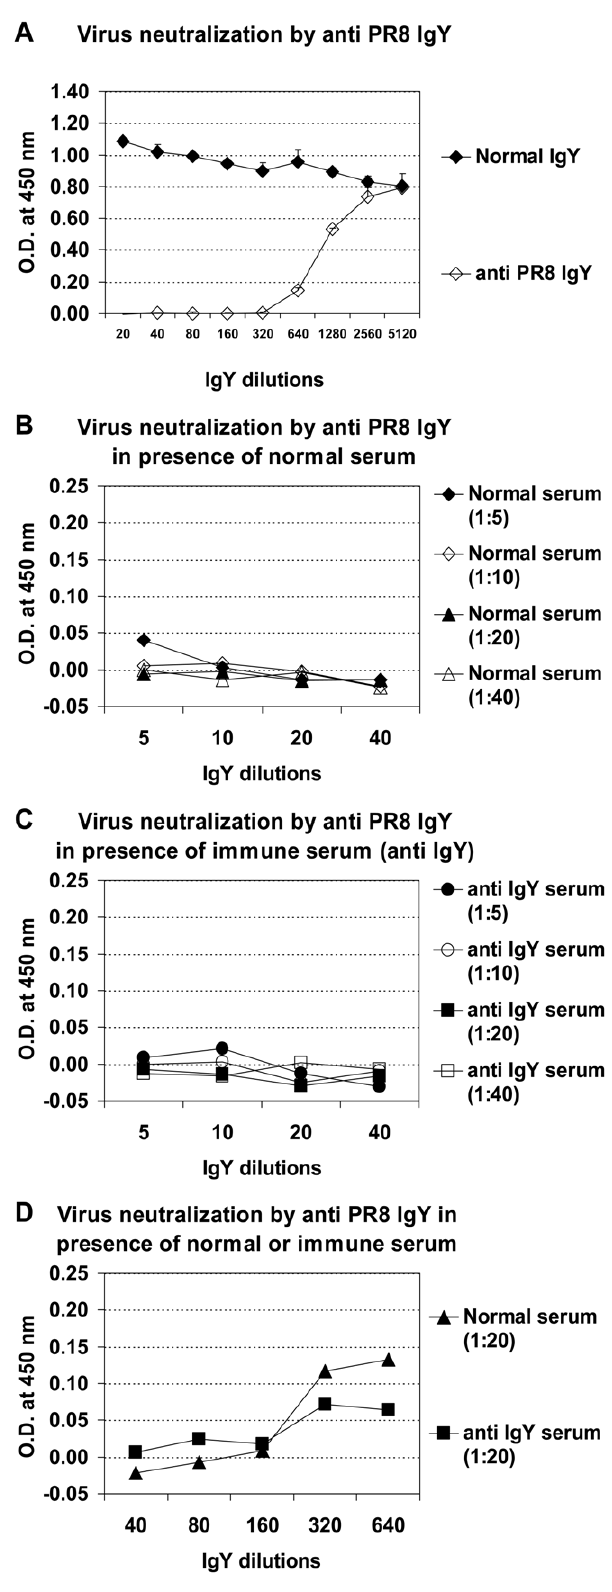
Figure 5. Anti-IgY Abs do not block neutralizing activity of virus specific IgY. PR8 virus neutralizing activity of PR8 specific IgY (anti-PR8 IgY) in the absence of anti-IgY serum was determined by microneutralization assay. VN titer of anti-PR8 IgY is 1:320 at which the